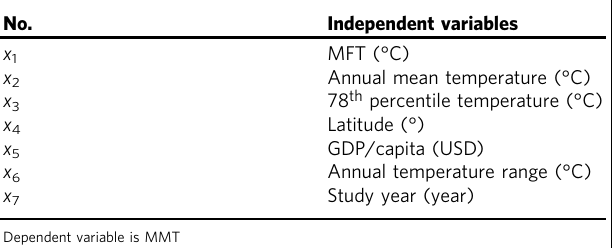
Table 1 Independent variables considered in the statistical analysis